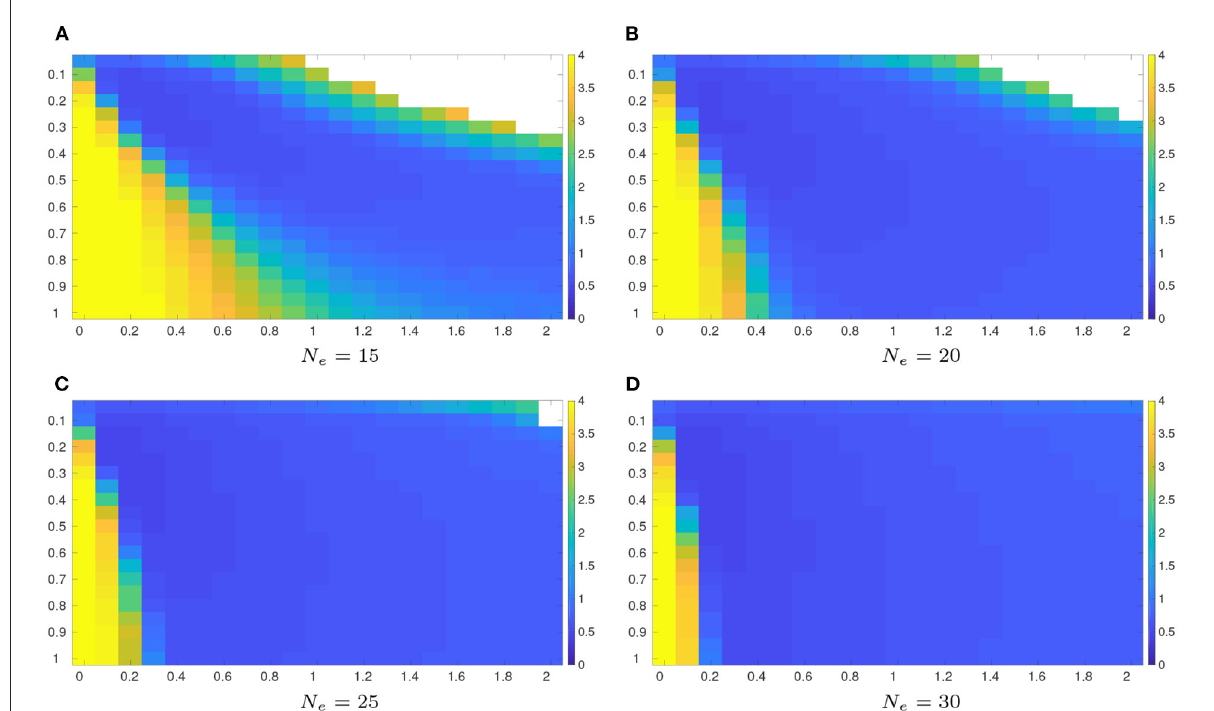
FIGURE1 Average RMSEs with respect to the reference algorithm (Equation 30) in the full observation scenario ( 1 n of 15, 20, 25, and 30, respectively. The RMSE values are obtained by searching all the possible combinations of the inflation factor δ filter divergence may take place (represented by white color in respective sub-plots). (A) N e = 15. (B) N e = 20. (C) N e = 25. (D) N e = 30.